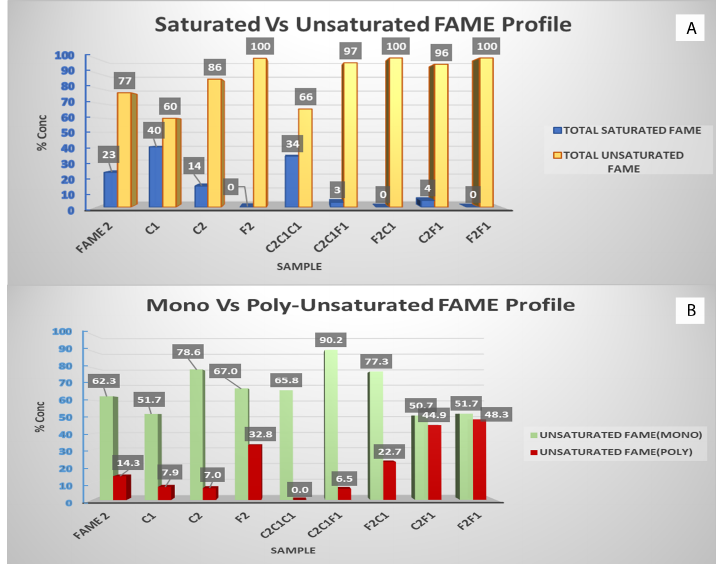
Figure 6. ( A ) Saturated vs. unsaturated methyl esters content on samples after urea crystallization. ( B ) Mono vs. poly-unsaturated methyl esters content on samples after urea crystallization. The concentration difference of saturated and unsaturated fatty acids before